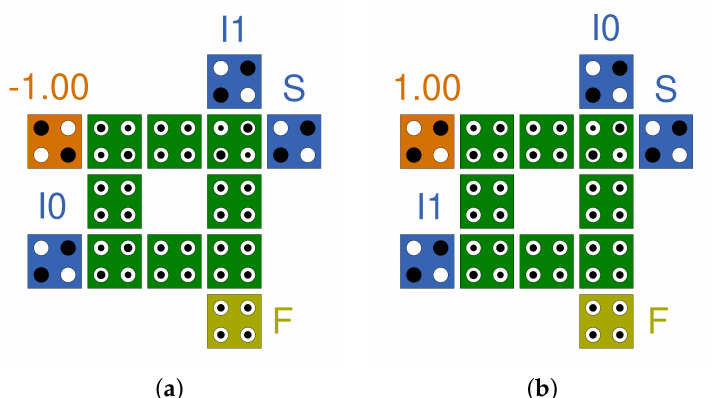
Figure 1. Two different QCA structures of 2 × 1 MUX: ( a ) Design with constant − 1.00 (MUX1); ( b ) Design with constant +1.00